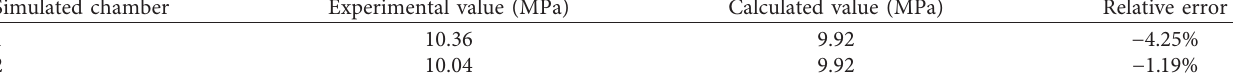
Table 2: Comparison of experimental value and theoretical value of peak shock wave overpressure in two simulated chambers.